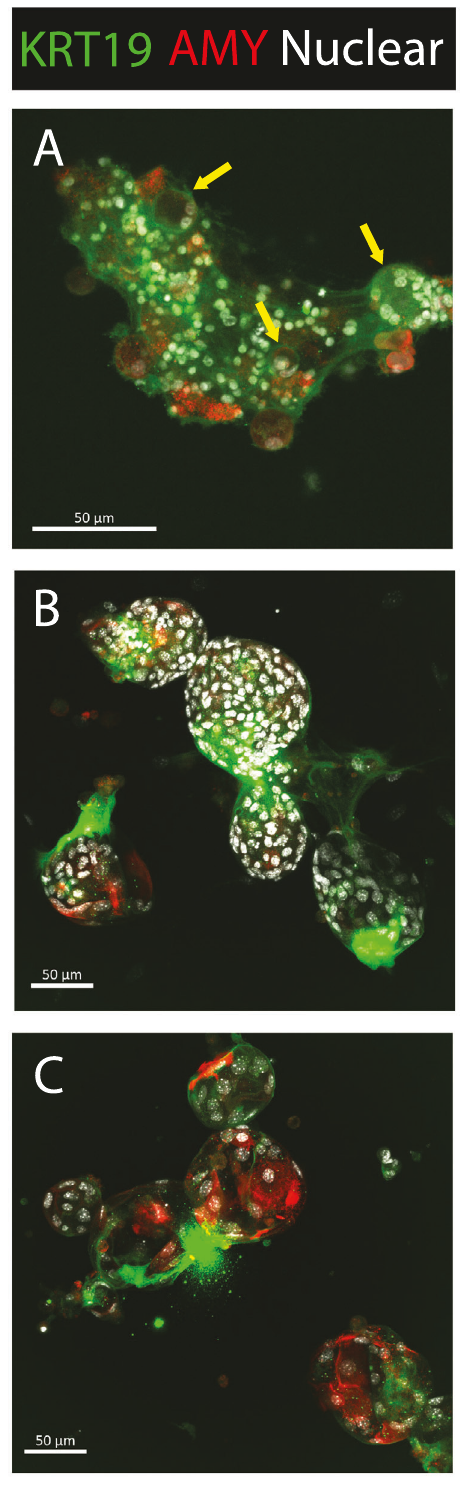
Fig. 6 Acinar and ductal changes during dedifferentiation of KC mouse acini by TSA. KC mouse pancreatic acini were plated onto Matrigel and were fi xed following one day of culture ( A ). Yellow arrows, ducts formed following ADM. After 2 complete days of culture the cells were either untreated ( B ) or exposed to 500 nM TSA ( C ) and cultured for 2 additional days before fi xation and immunostaining. Scale bars: 50